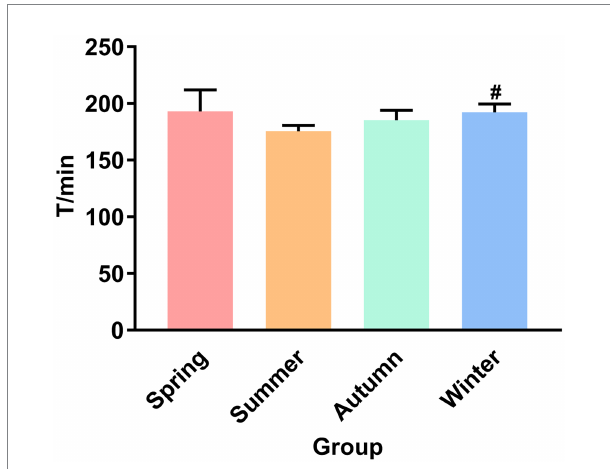
FIGURE 1 Fecal excretion time. # P < 0.05 compared with the summer